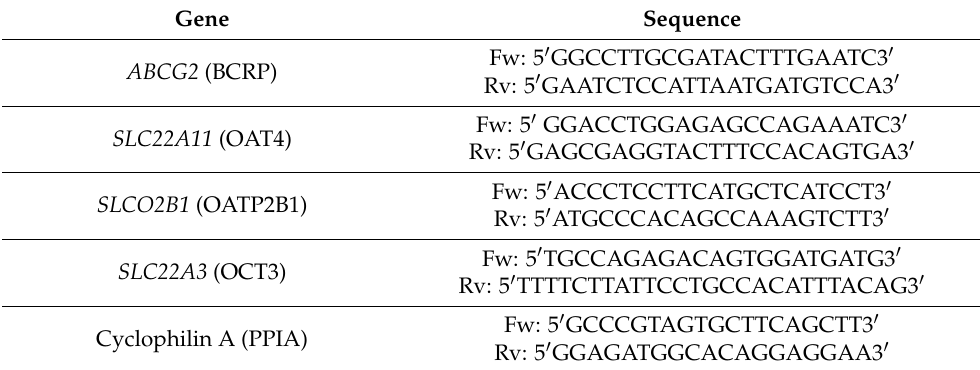
Table 1. Primer sequences used for